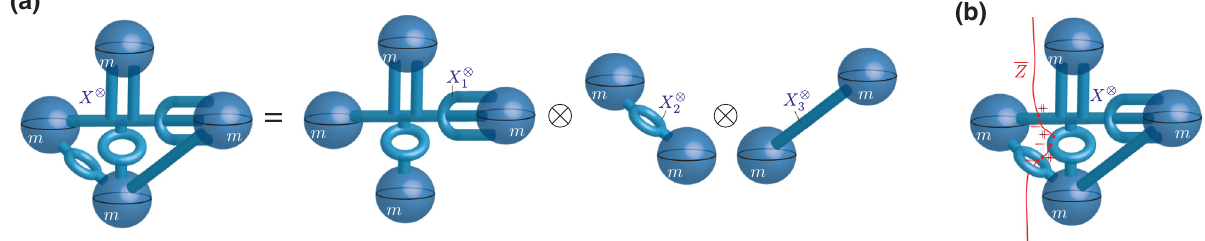
FIG. 20. (a) The generic situation considered in Proofs 3a and 3b, where a local X -brane operator connects multiple m -holes and can be decomposed as a tensor product of several connected components. (b) The macroscopic logical string Z has zero algebraic intersection with the local X -brane, since the string enters and leaves the interior of the punctured closed 2-manifolds formed by the X -brane operator the same number of